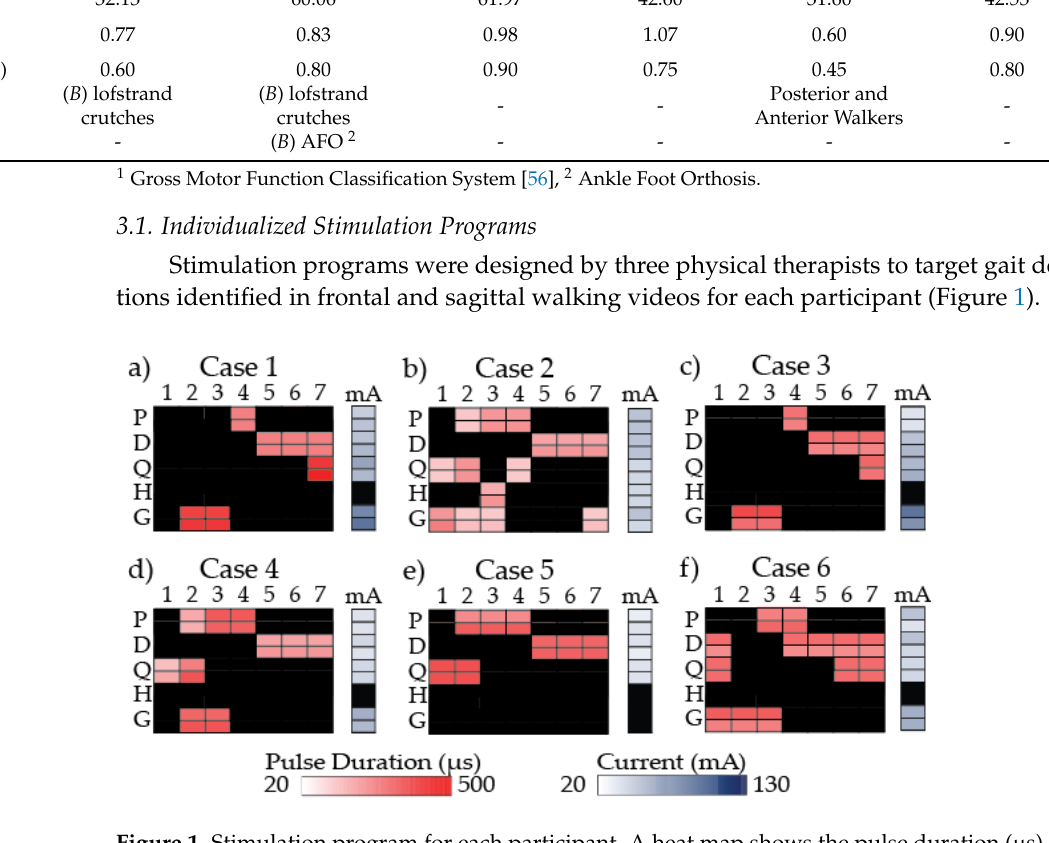
Figure 1. Stimulation program for each participant. A heat map shows the pulse duration ( µ s) used for each gait phase (column) and muscle group (row) and current ( mA ) used for each muscle group. For each muscle group, there is a left side (top row) and right side (bottom row). Darker colors are associated with higher pulse duration in red and higher current in blue. Black indicates no stimulation. 1: loading response; 2: mid-stance; 3: terminal stance; 4: pre-swing; 5: initial swing; 6: mid-swing; 7: terminal swing; mA: current; P: plantarflexors; D: dorsiflexors; Q: quadriceps; H: hamstrings; G: gluteals.